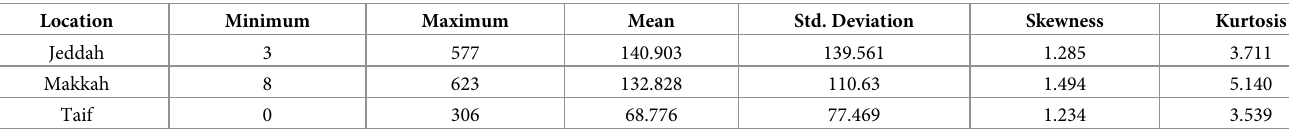
Table 1. Descriptive statistics of COVID-19 cases.